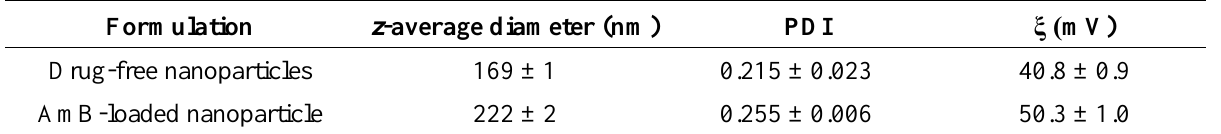
Table 2. Z -average diameters; polydispersity indices (PDI); zeta potentials (ξ) of drug-free and AmB-loaded lipid nanoparticulate dispersions ( n = 3).